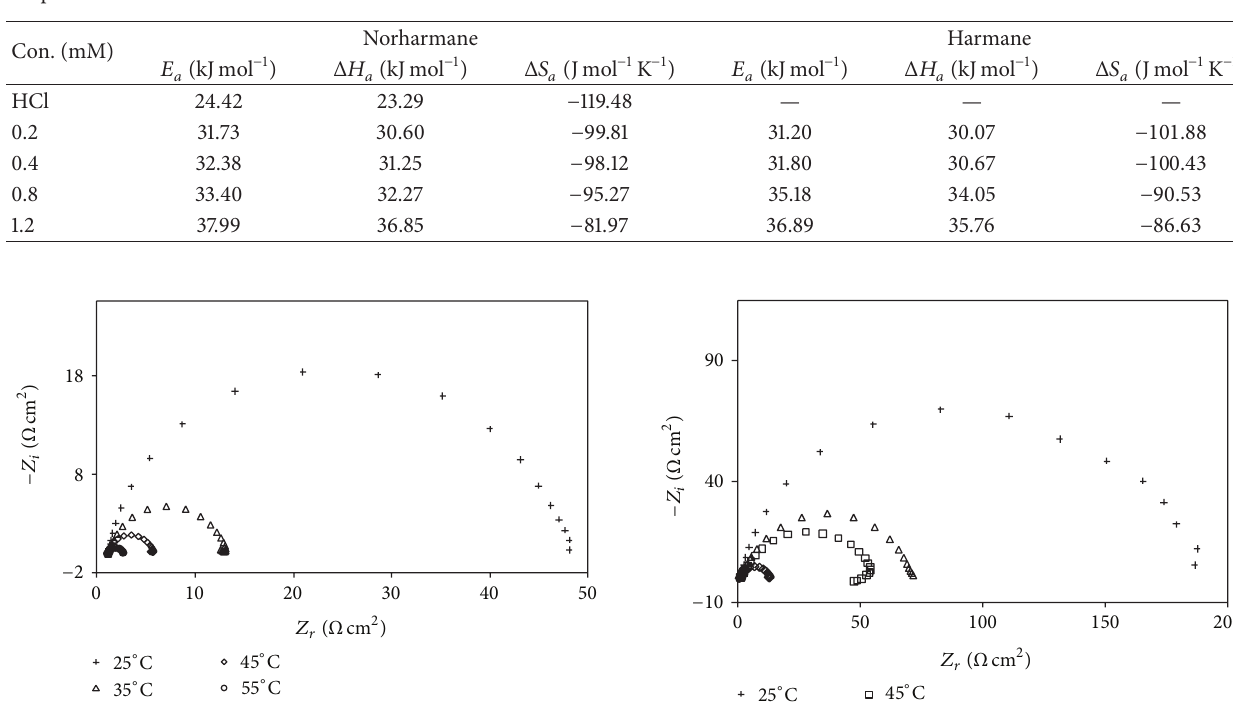
Table 3: Thermodynamic parameters calculated from Tafel plots for the adsorption of indole derivates in 1M HCl on the C38 steel at different temperatures.